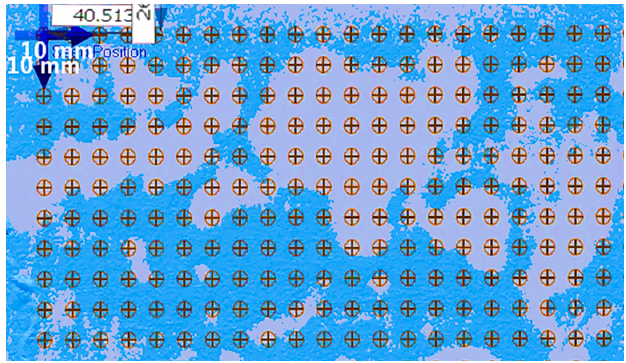
Figure 3. 11 × 21 grid of comparison points for damage region as evaluated within 3D scanning software; blue patterned background is 3D scan point cloud data.